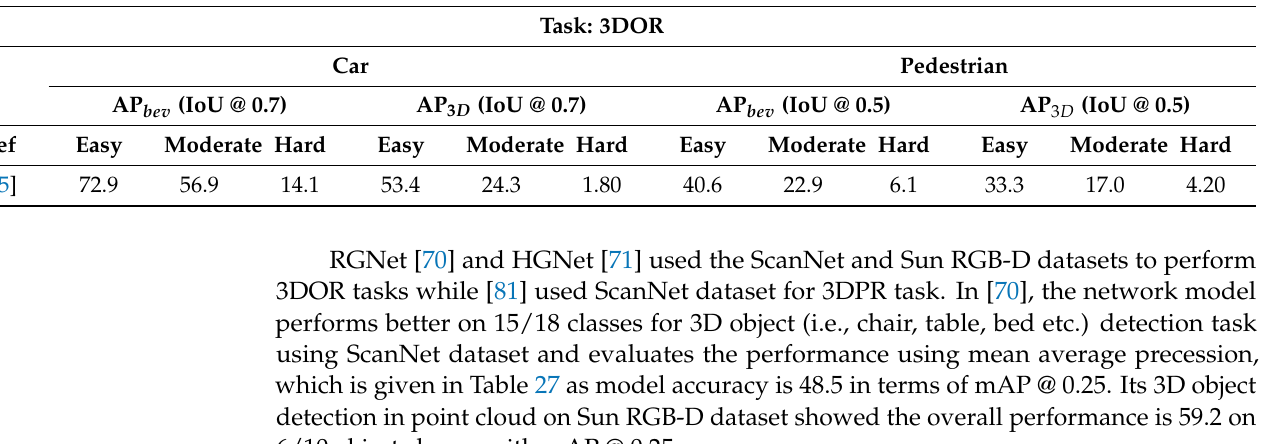
Table 26. Comparison of the Results on the Argoverse Dataset. Argoverse